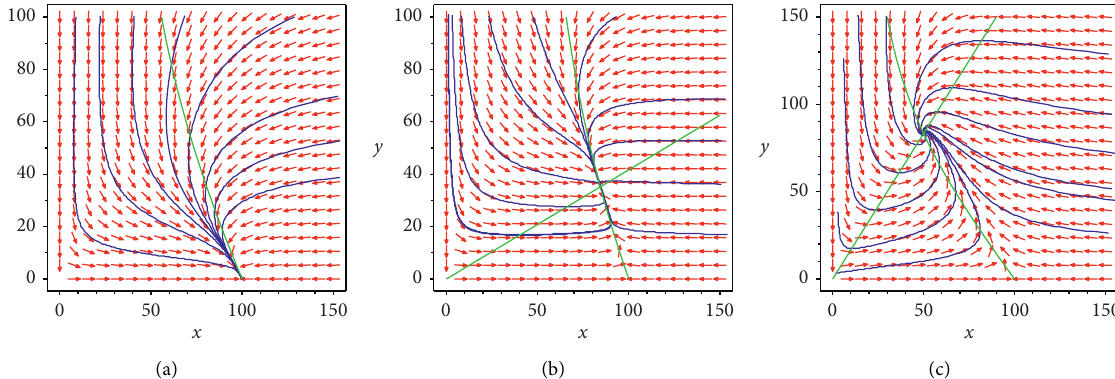
Figure 1: Phase diagram for system (1). (a) Boundary equilibria. (b) Internal equilibrium is a node. (c) Internal equilibrium is a